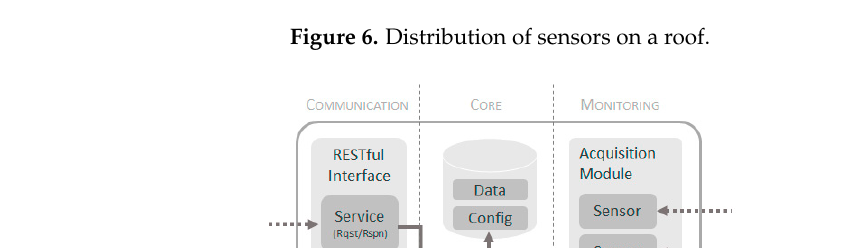
Figure 6. Distribution of sensors on a roof.